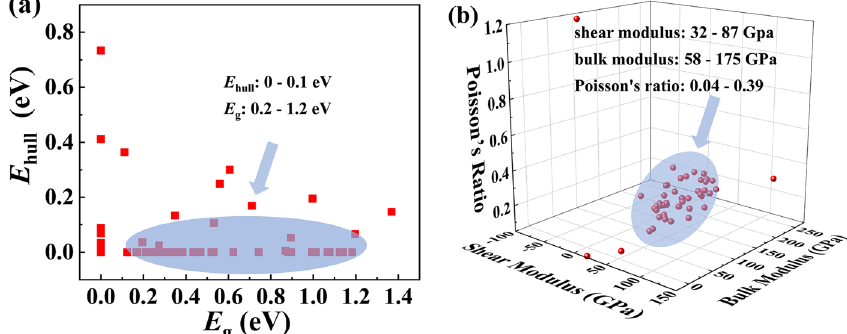
Fig. 4 Distribution of the 61 potential TE materials. Scatter plot of a E hull versus E g and b bulk modulus and Poisson ’ s ratio versus shear